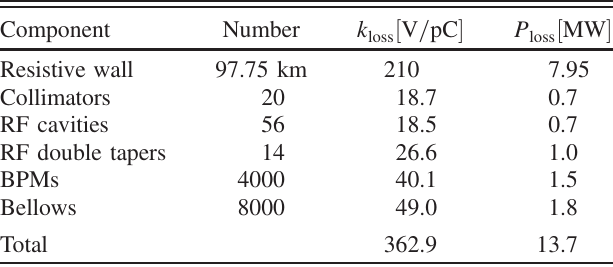
TABLE IV. Power loss contribution of the main FCC-ee components at nominal intensity and bunch length, in the lowest energy case of 45.6 GeV.